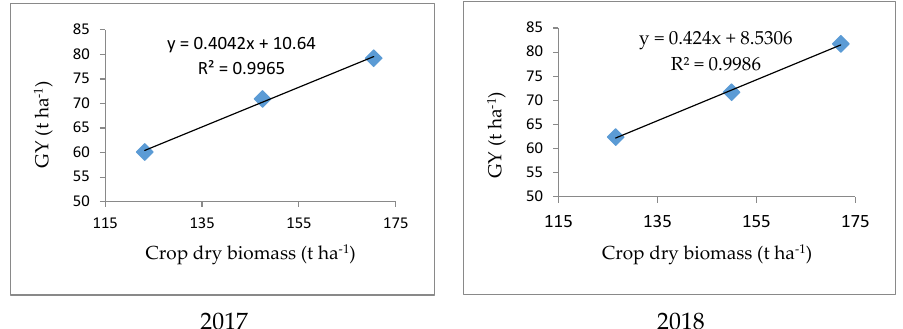
Figure 5. Linear regression line among crop establishment methods between dry matter accumulation vs. Grain yield (GY).